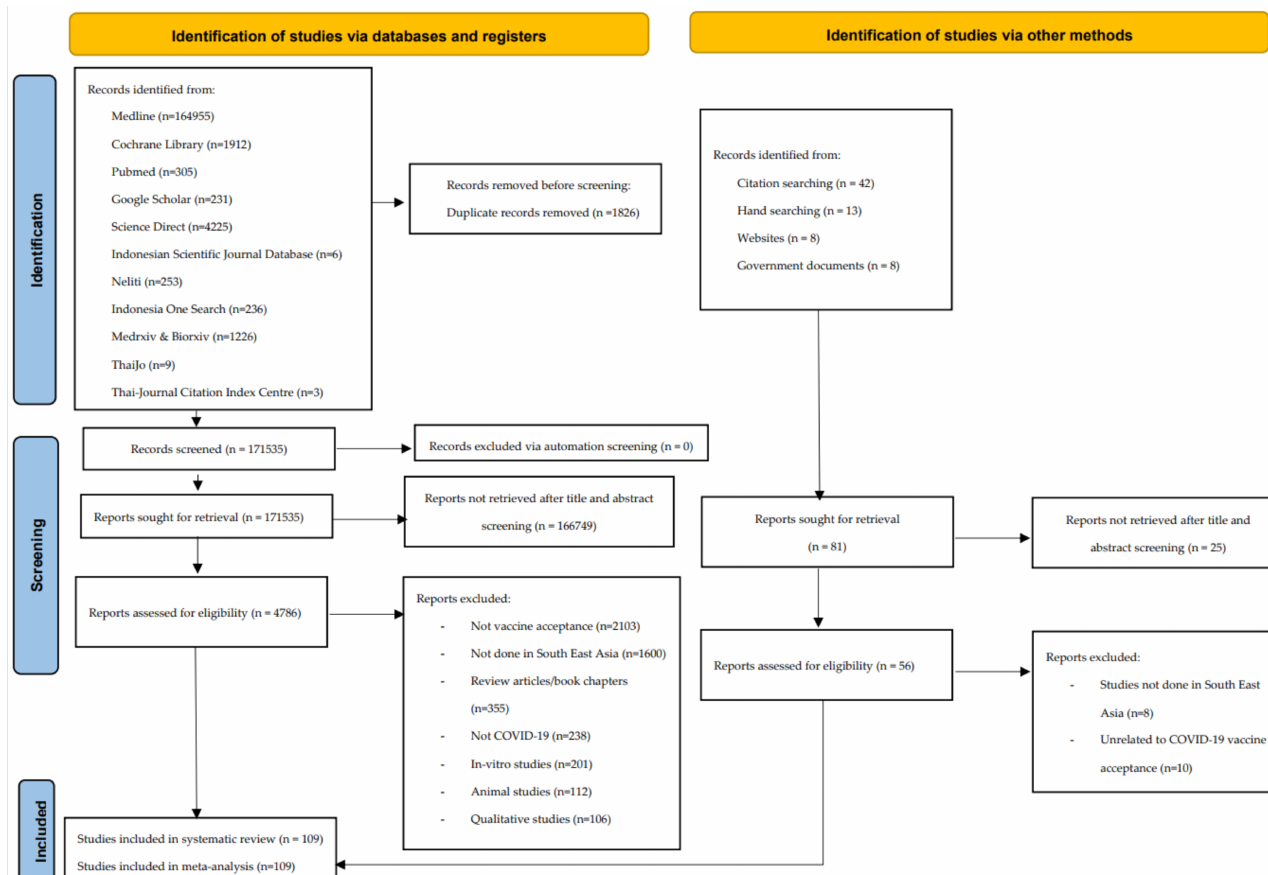
Figure 1. PRISMA flowchart for the selection of included